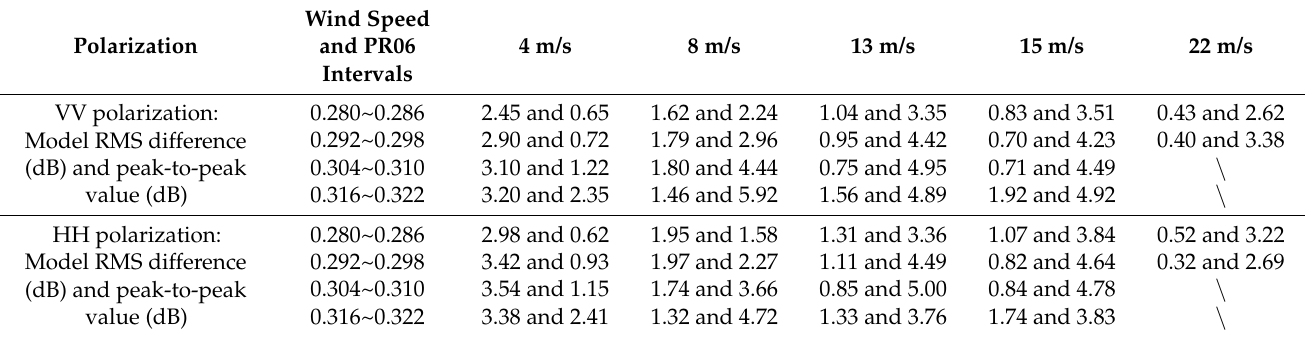
Table 3. RMS difference between model results and backscatter measurements (model RMS differ- ence), and peak-to-peak value of the backscatter with wind direction (peak-to-peak